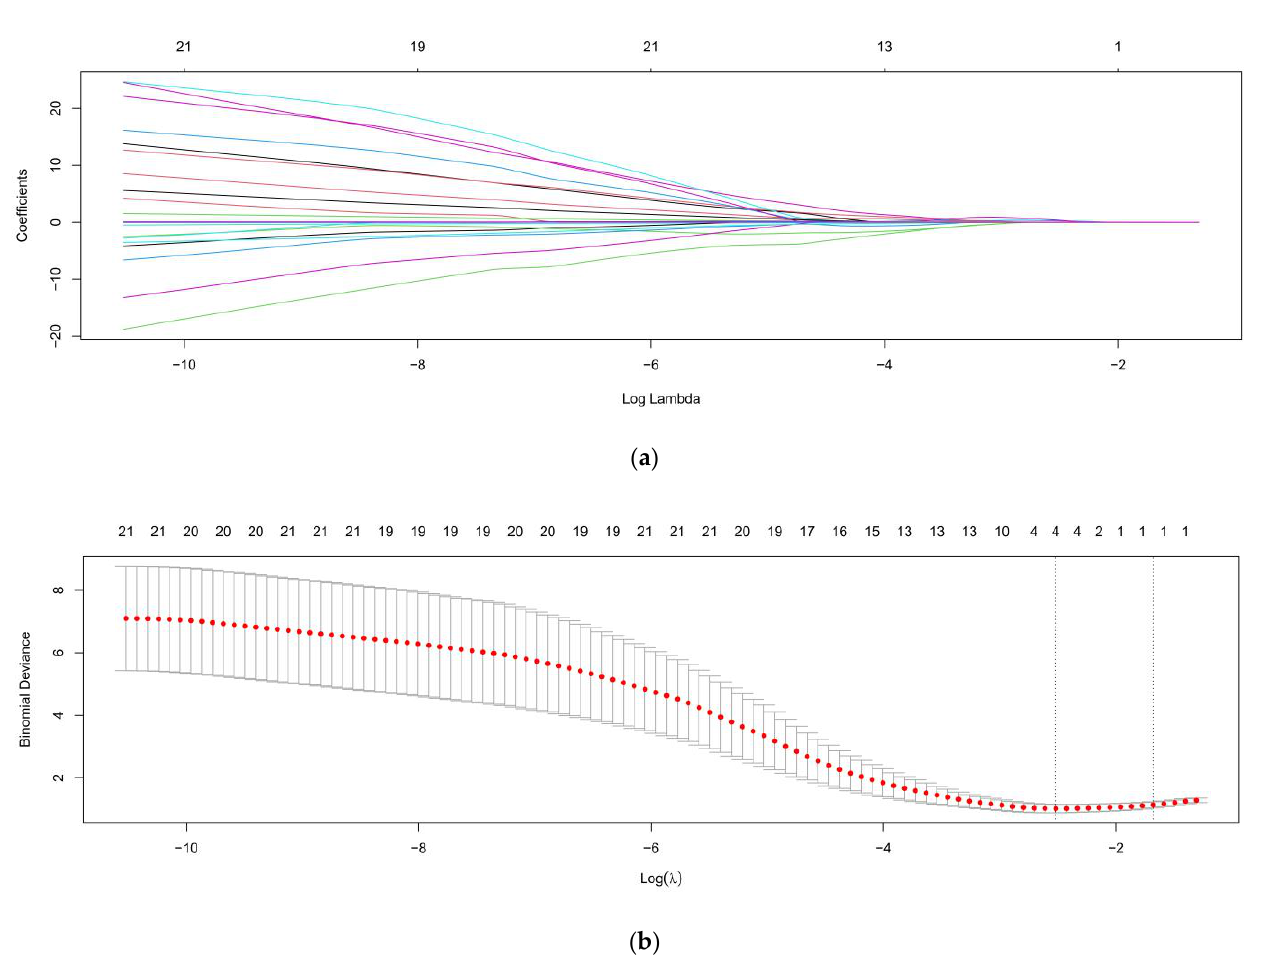
Figure 1. Clinical variables were selected using LASSO logistic regression model: ( a ) Shrinkage of coefficients by hyperparameter (λ) ; ( b ) Hyperparameter selection (λ) using cross validation. The dotted line indicates the value of the harmonic log (λ) when the error of model is minimized. In the LASSO logistic regression model, only one variable (time from injury to initial operation) was selected when log (λ) was −0.1772.